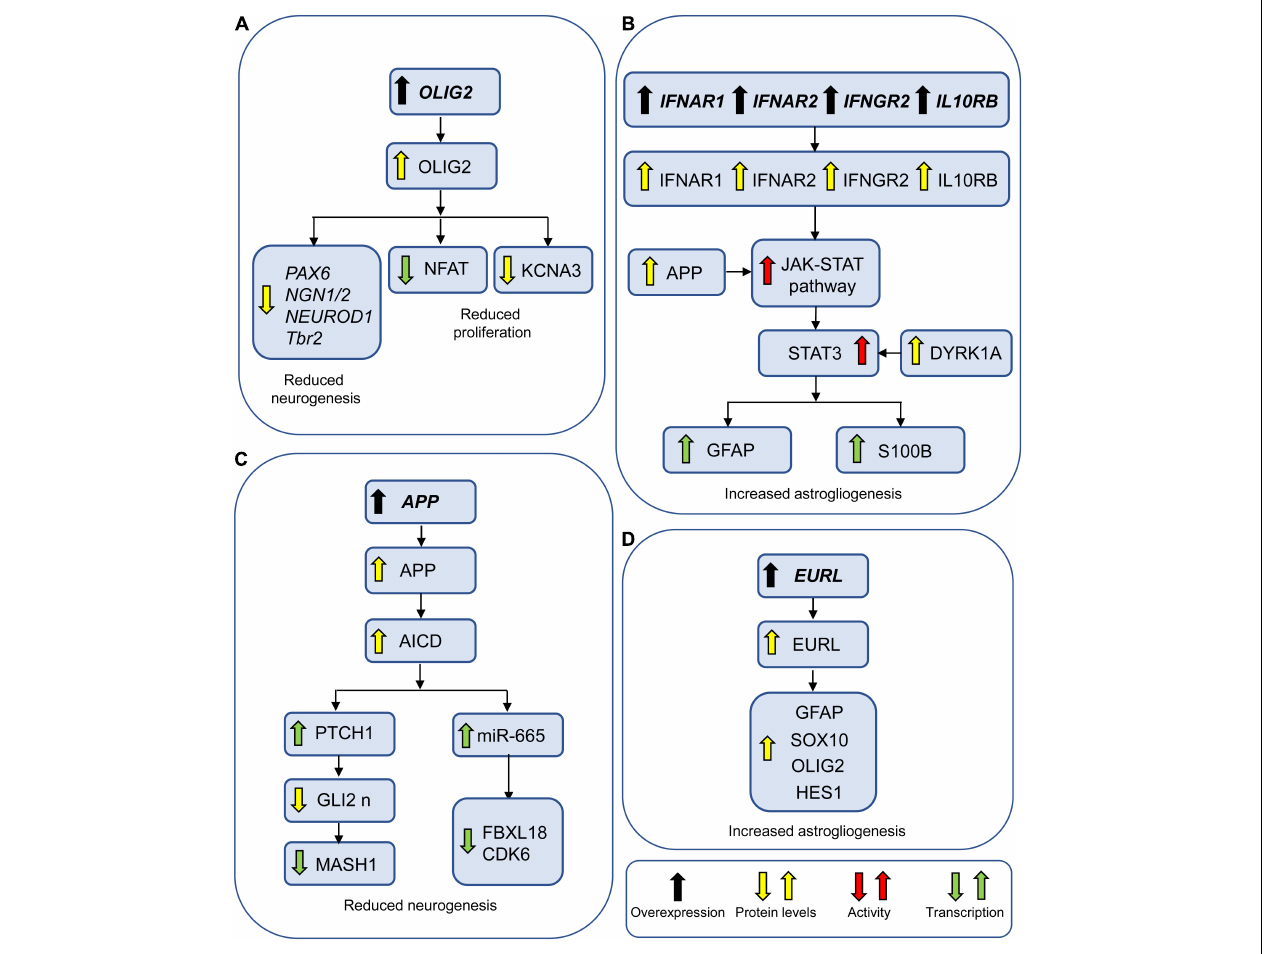
FIGURE 7 | Genes involved in neurogenesis and gliogenesis alterations in DS. (A) OLIG2 may reduce neurogenesis by reducing transcription of proneural factors. It may additionally impair NPC proliferation by reducing the expression of NFAT and the protein levels of the potassium channel KCNA3. (B) IFNAR1 , IFNAR2 , and IFNGR2 may increase astrogliogenesis by activating the JAK-STAT pathway. APP and DYRK1A potentiate this effect by enhancing the activation of JAK-STAT pathway and STAT3, respectively. (C) AICD may reduce neurogenesis by causing overexpression of PTCH1 and miR-655. (D) EURL may favor astrogliogenesis by upregulating astroglial factors. Abbreviations: APP, amyloid beta precursor protein; EURL, early undifferentiated retina and lens; GLI2 n, nuclear GLI2; and OLIG2, oligodendrocyte transcription factor